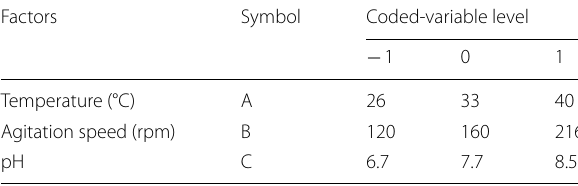
Table 1 Level of factors used in experimental